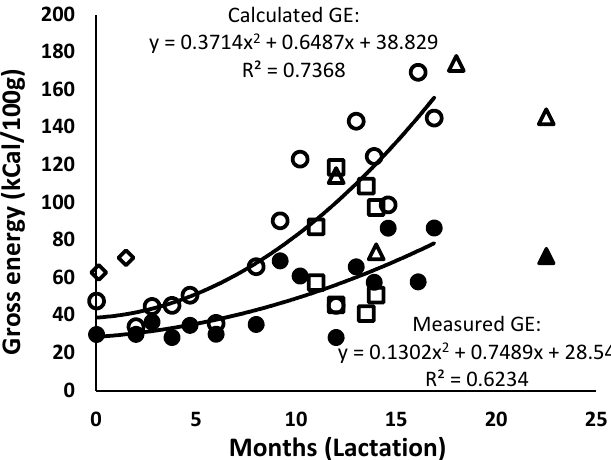
Figure 8. Changes in measured (solid symbols) and calculated (open symbols) energy in milk of African elephants during lactation (Shorty ( ● ○ ), Bloem ( ◊ ) Mussina ( ■ □ ), and others ( ▲ Δ )). The trend lines for the combined data were y = 27.946e 0.005x and R 2 = 0.5621 for the measured energy content (GE) and y = 0.1079x 2 + 3.5884x + 41.778 and R 2 = 0.6571 for the calculated GE.